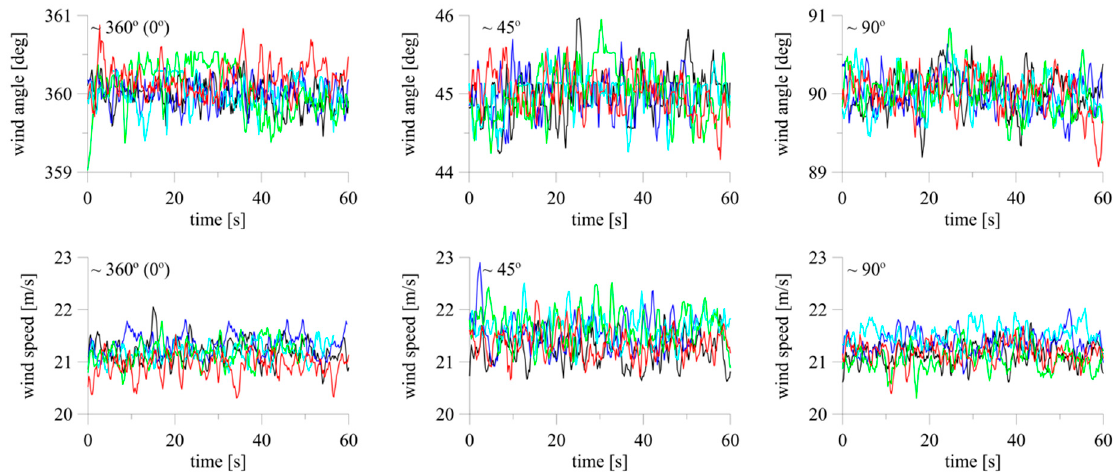
Figure 7. Fluctuations of wind speed and angle for 2D anemometers. Colors differentiate anemometers A1–A5.